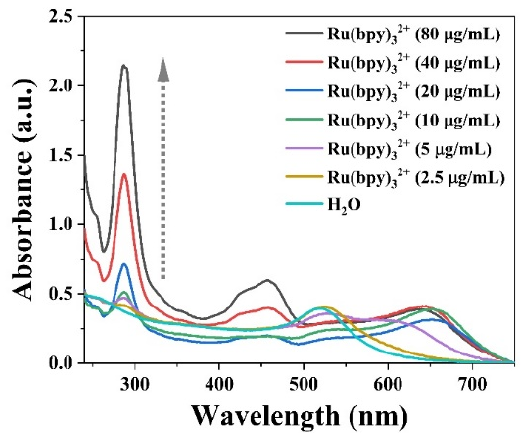
Figure 2. UV-Vis absorption spectra of mixed solutions of Ru(bpy) 3 2+ at different concentrations and colloidal gold.